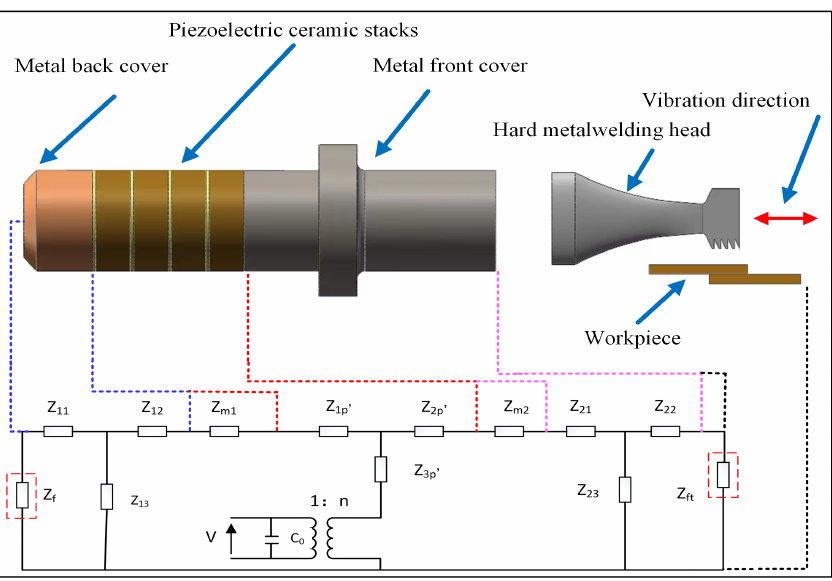
Figure 1. Electromechanical equivalent model of the piezoelectric